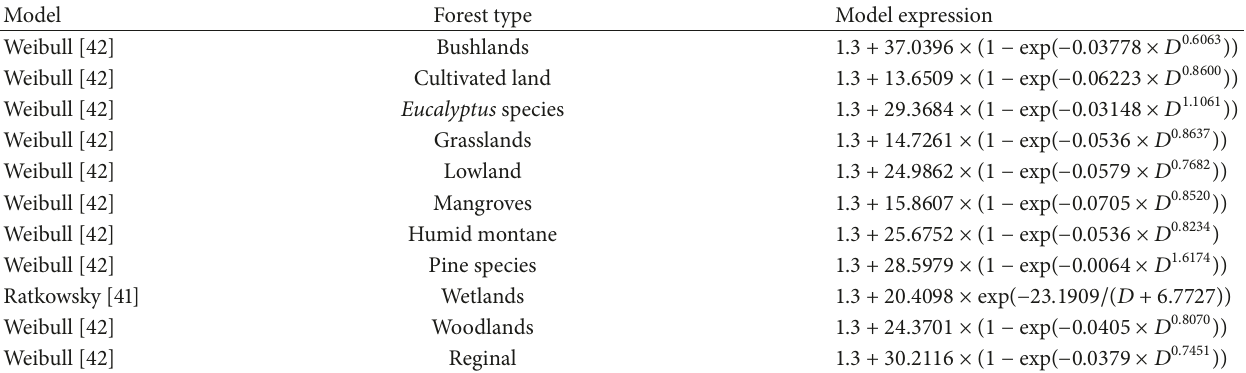
Table 4: Best selected height base